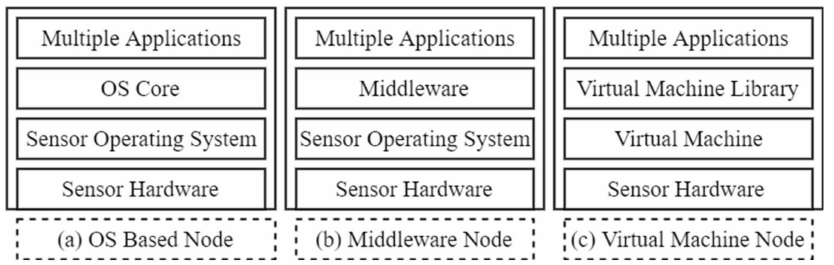
Figure 4. ( a ) OS-based Solution ( b ) Middleware-based solution ( c ) VM-based